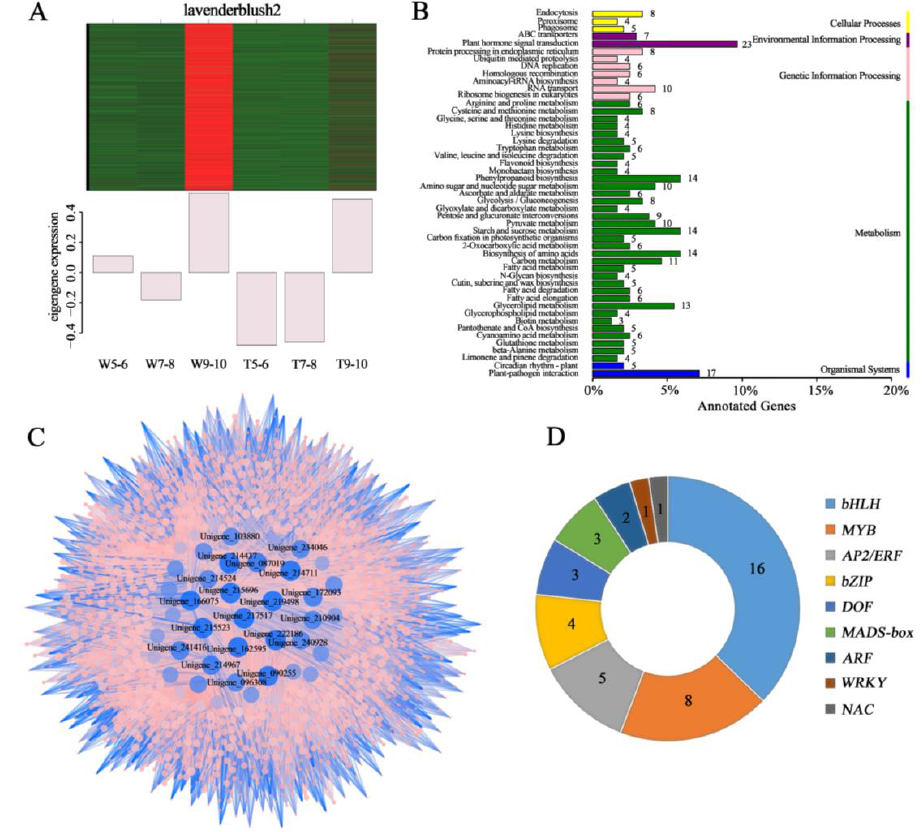
Figure 4. The expression pattern, annotation, and network prediction of genes in the lavenderblush2 module. ( A ) Expression pattern of eigengenes in the lavenderblush2 module. ( B ) KEGG pathways significantly enrich genes in the lavenderblush2 module. ( C ) Network of the top 50 hub genes from the lavenderblush2 module, which showed a high correlation with carotenoid accumulation. ( D ) Statistics on the number of important transcription factors in the lavenderblush2 module.